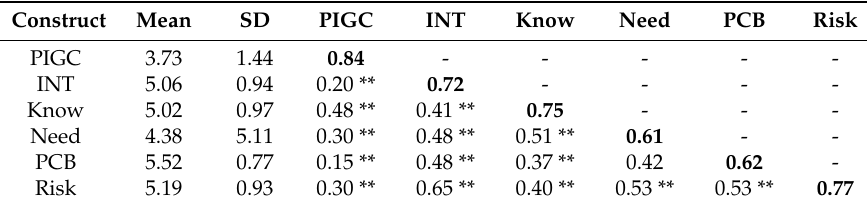
Table 3. Means, standard deviation, and